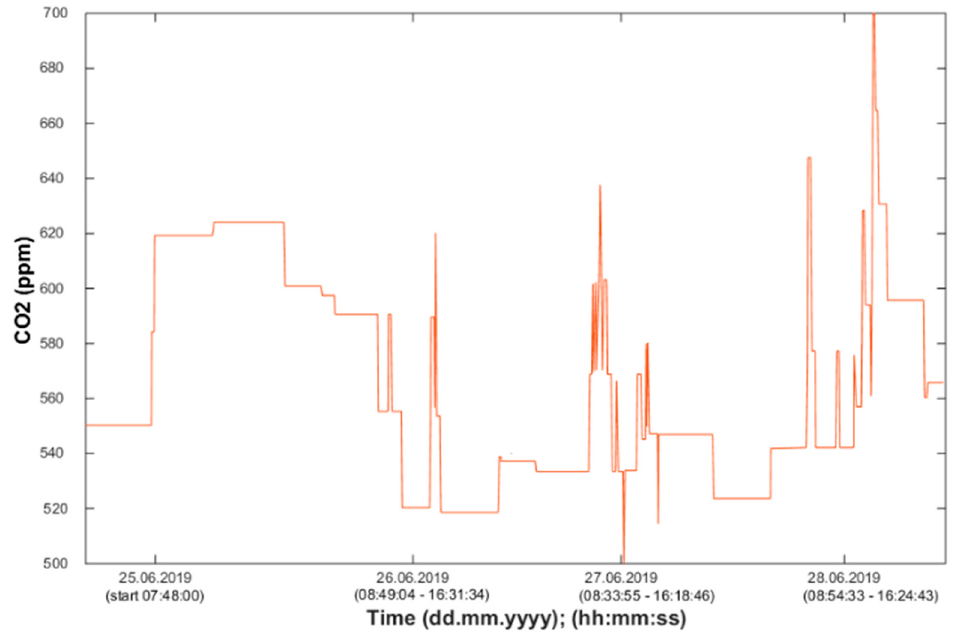
Figure 14. Waveforms of the CO 2 concentration values measured in SH room R104 (BT 12.09).